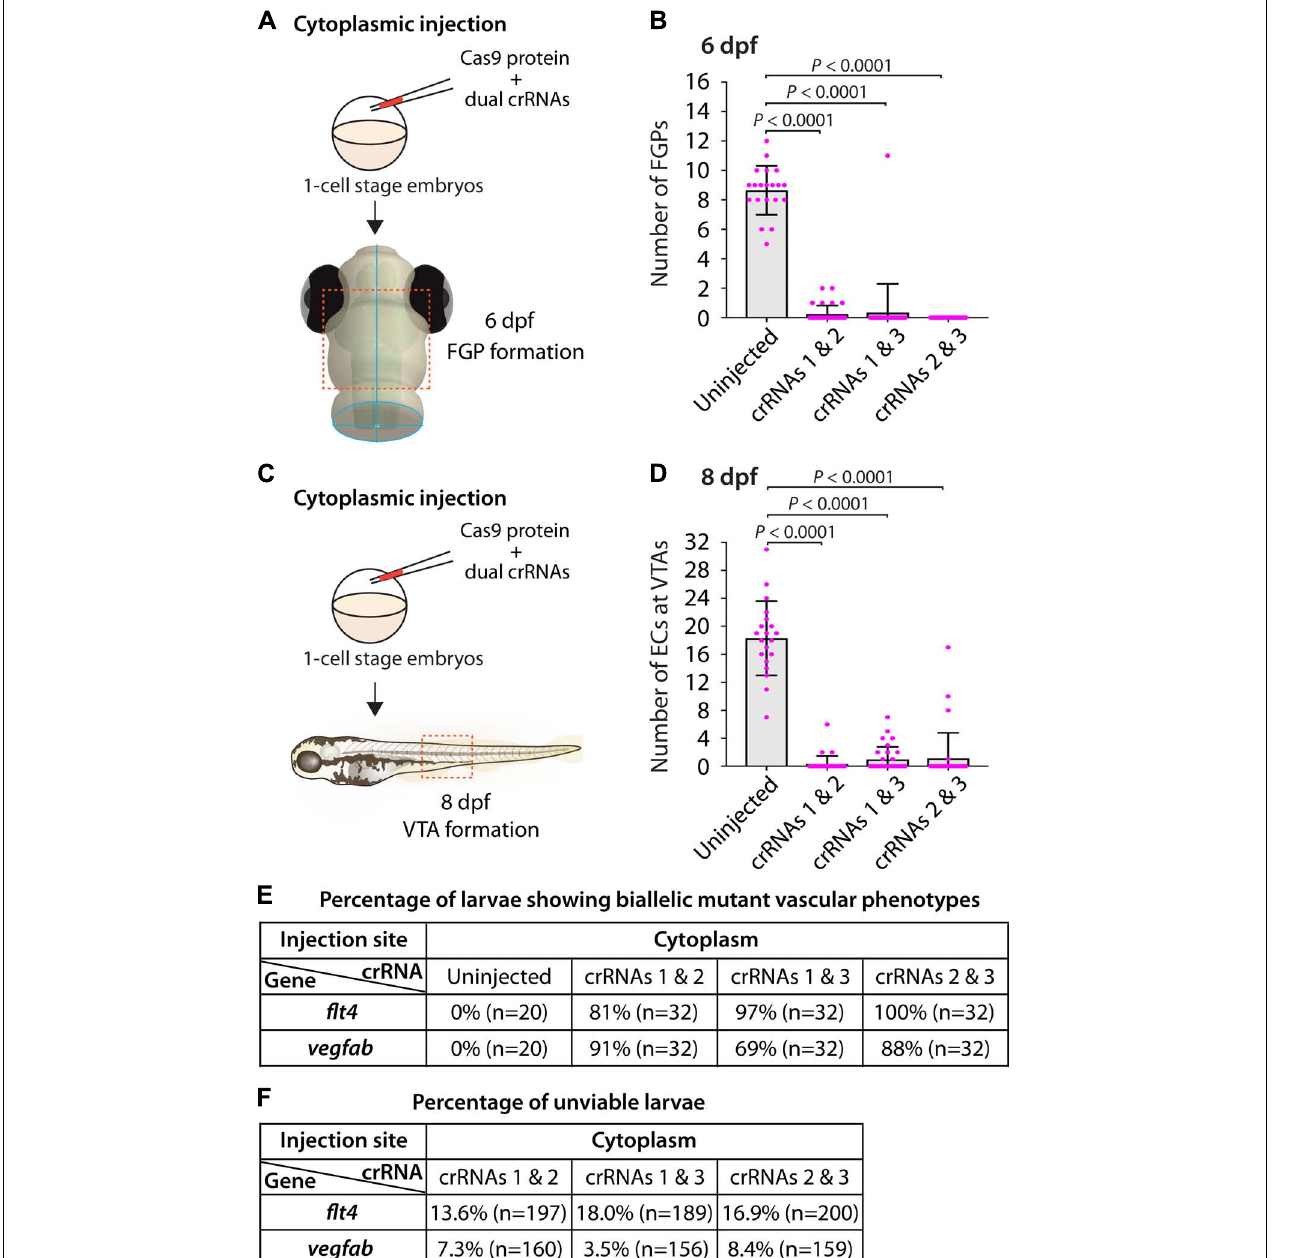
FIGURE 7 | Cytoplasmic injections of two dgRNPs per gene led to variable efficiency of biallelic gene disruptions in F0 animals. (A) Experimental workflow of the cytoplasmic microinjection experiments for panel (B) . Injection cocktails containing Cas9 protein with two unique flt4 crRNA:tracrRNA duplexes were injected into the cytoplasm of one-cell stage Tg(fli1:nEGFP);Tg(lyve1:DsRed) embryos. Injected progeny were analyzed at 6 dpf for FGP formation over the optic tectum. (B) Quantification of FGPs over the optic tectum at 6 dpf after cytoplasmic injection of Cas9 protein with the two indicated flt4 crRNA:tracrRNA duplexes ( n = 20 for uninjected controls; and n = 32 for flt4 crRNAs1&2, crRNAs1&3, and crRNAs2&3). Injections of two unique flt4 dgRNPs led to varying degrees of FGP loss over the optic tectum. (C) Experimental workflow of the cytoplasmic microinjection experiments for panel (D) . Injection cocktails containing Cas9 protein with two unique vegfab crRNA:tracrRNA duplexes were injected into the cytoplasm of one-cell stage Tg(kdrl:EGFP);Tg(kdrl:NLS-mCherry) embryos. Injected progeny were analyzed for VTA formation at 8 dpf. (D) Quantification of ECs at the VTAs within a 5 somite region per animal at 8 dpf after yolk injection of Cas9 protein with the two indicated vegfab crRNA:tracrRNA duplexes ( n = 20 for uninjected controls; and n = 32 for vegfab crRNAs1&2, crRNAs1&3, and crRNAs2&3). (E) A summary table listing the percentage of larvae of the indicated treatment that displayed biallelic mutant vascular phenotypes. A complete absence of FGPs at 6 dpf ( flt4 ), or of VTAs at 8 dpf ( vegfab ), were defined as biallelic mutant vascular phenotypes. (F) A summary table listing the percentage of unviable larvae following the indicated treatment. The number of the animals examined for each treatment is listed in the panel. A one-way ANOVA followed by Tukey’s post hoc test was used to calculate P values for panels (B,D)